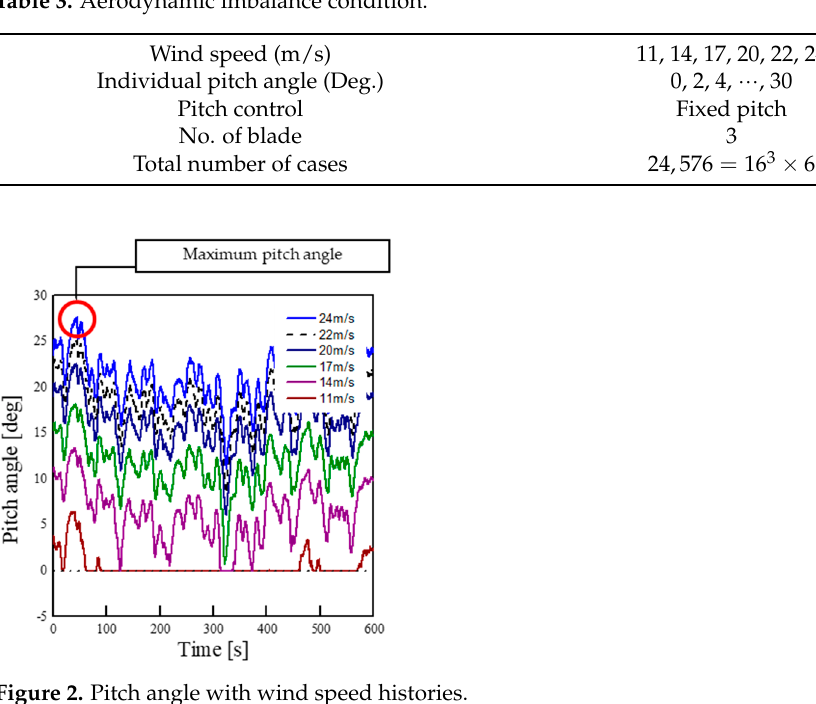
Table 3. Aerodynamic imbalance condition.